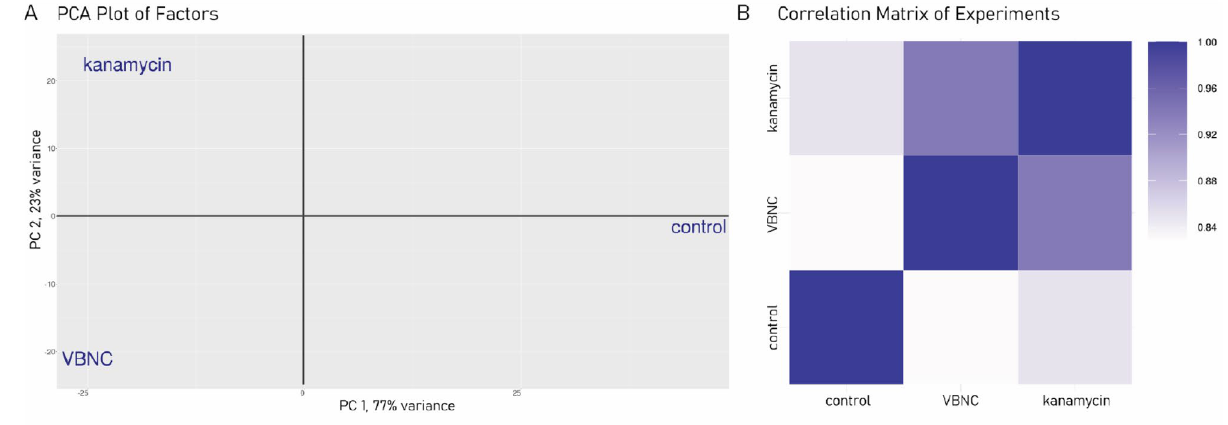
Figure 1. Similarities in the gene expression profiles across tested conditions. ( A ) PCA analysis. The gene expression for each condition represents an average of three biological samples. ( B ) Pearson’s correlation matrix of the same conditions as in (A). The maximum correlation value is 1 (including self-correlation). The correlation values for the three conditions ranged from 0.83 to